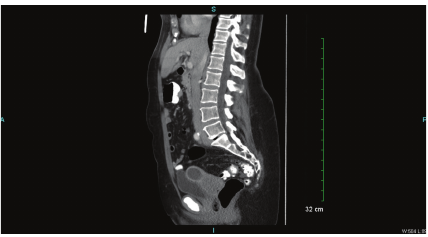
Figure 2: CT scan of abdomen and pelvis showing fluid-filled and distended uterine endometrial cavity with free fluid in the posterior cul-de-sac.